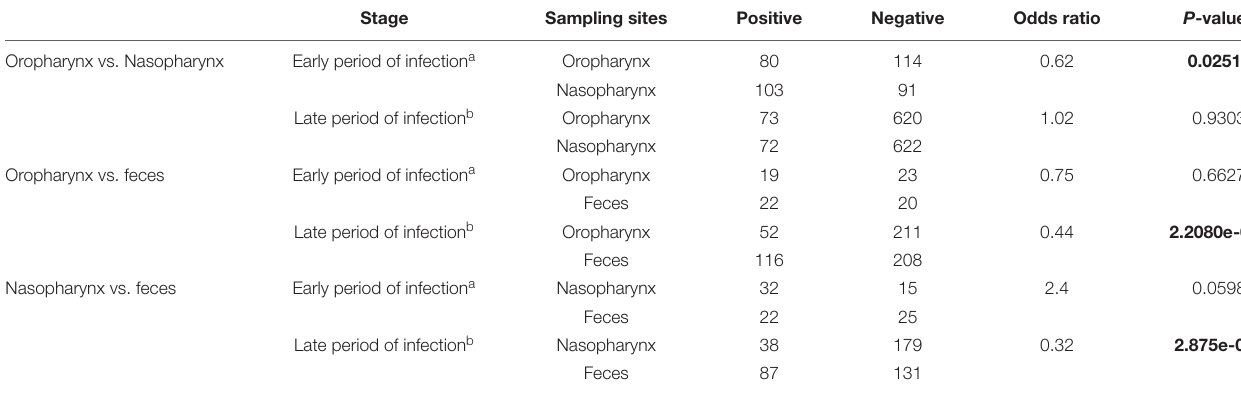
TABLE 2 | Statistically significant analysis of different COVID-19 positive detectable rate between feces and oropharynx/nasopharynx swab in the early and late period of infection.